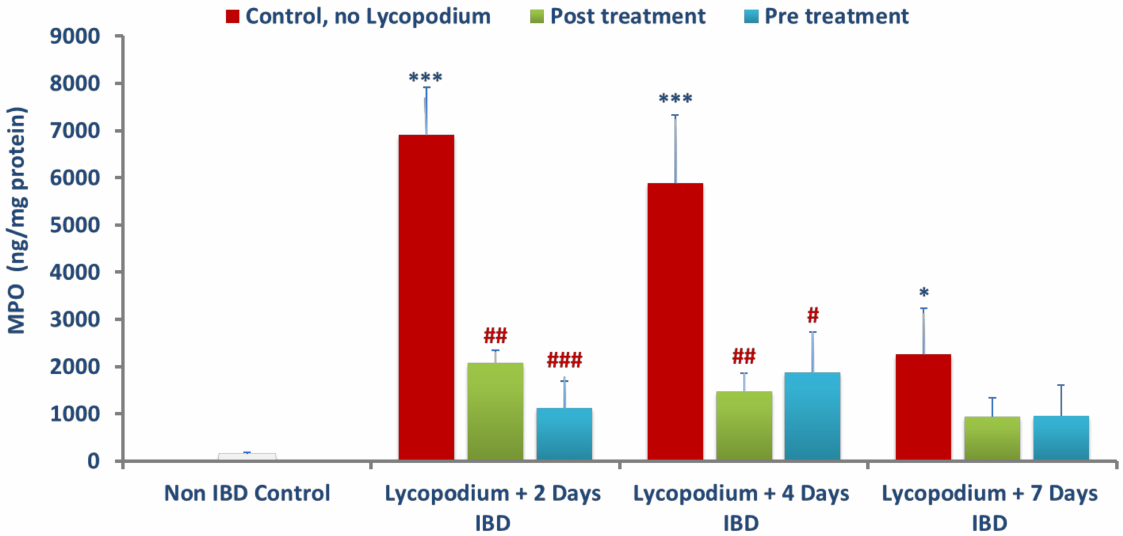
Figure 5. Effect of lycopodium on MPO in acetic acid-induced IBD in rats. Results are mean ± SEM; * p < 0.05, *** p < 0.001 vs. non IBD control group; # p < 0.05, ## p < 0.01, ### p < 0.001 vs. relative IBD control group.